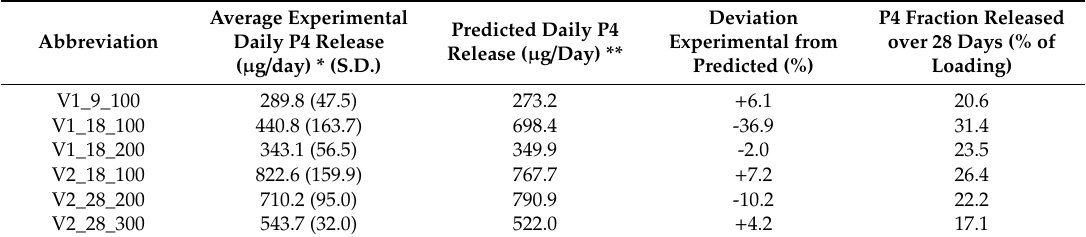
Table 2. In-vitro progesterone (P4) dissolution data generated from the VCM systems. * The average daily release was calculated between day 3 and day 28. ** Predicted values using the equilibrium P4 solubility in the core polymer and the measured membrane thickness in Equation (2) (Section